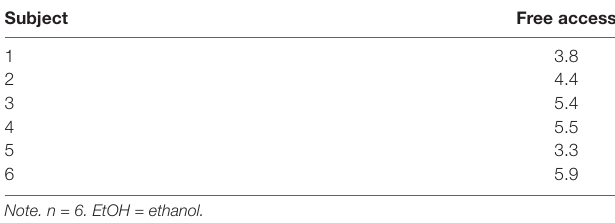
TABLE 1 | Amount of EtOH consumed by subjects during the Free-Access Period in grams/kilogram.